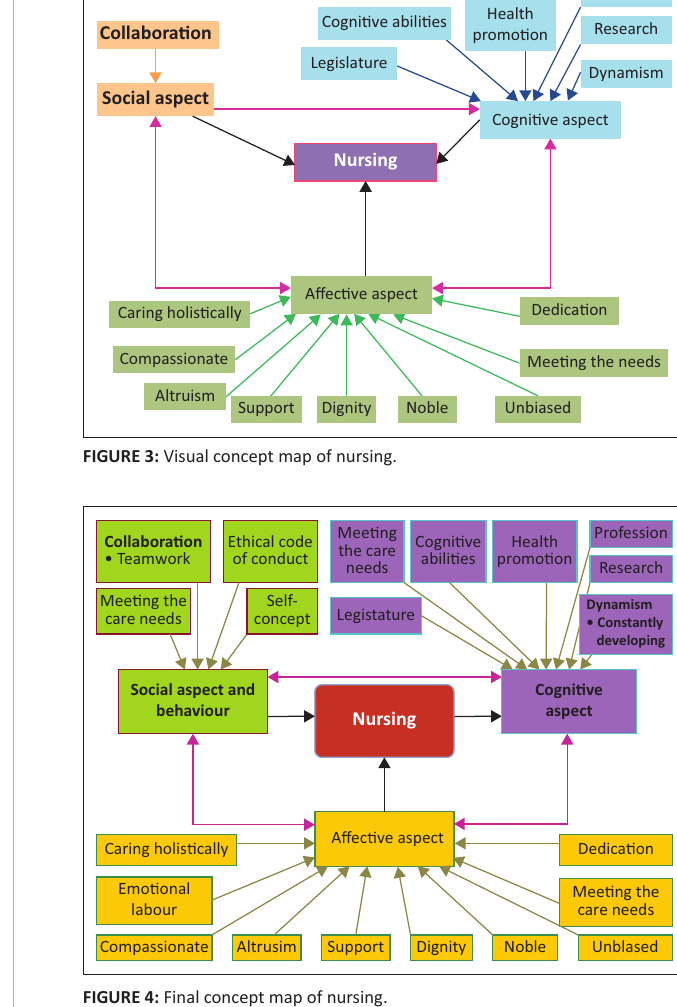
FIGURE 4: Final concept map of nursing.